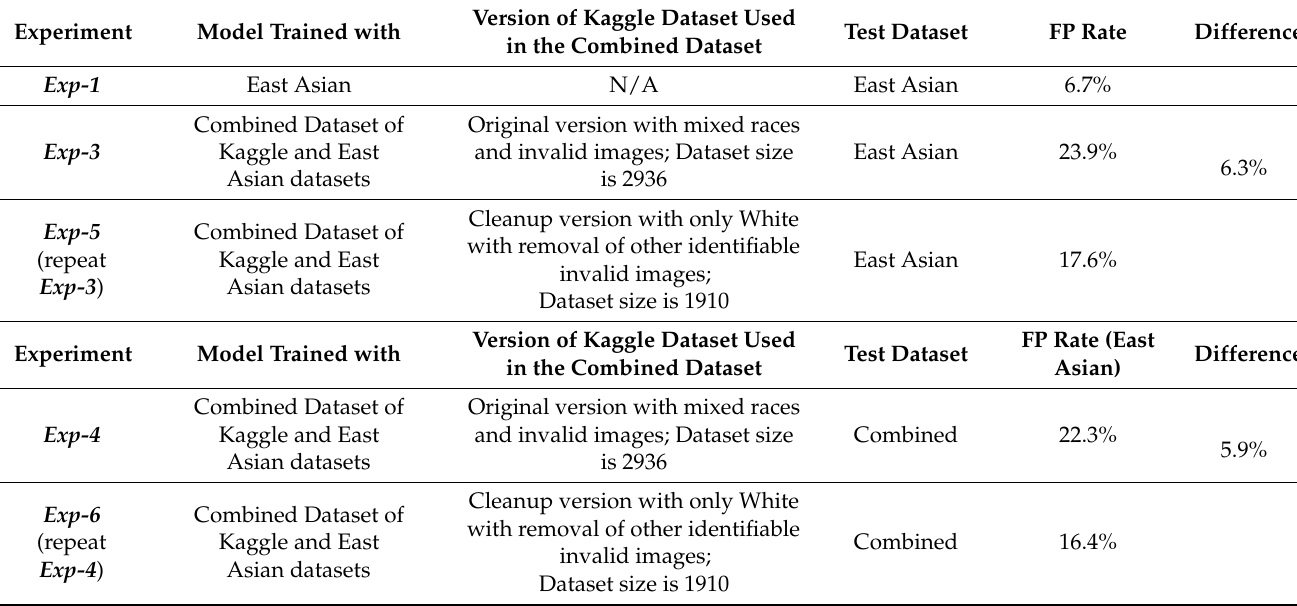
Table A5. Results comparison regarding the effect of Kaggle dataset